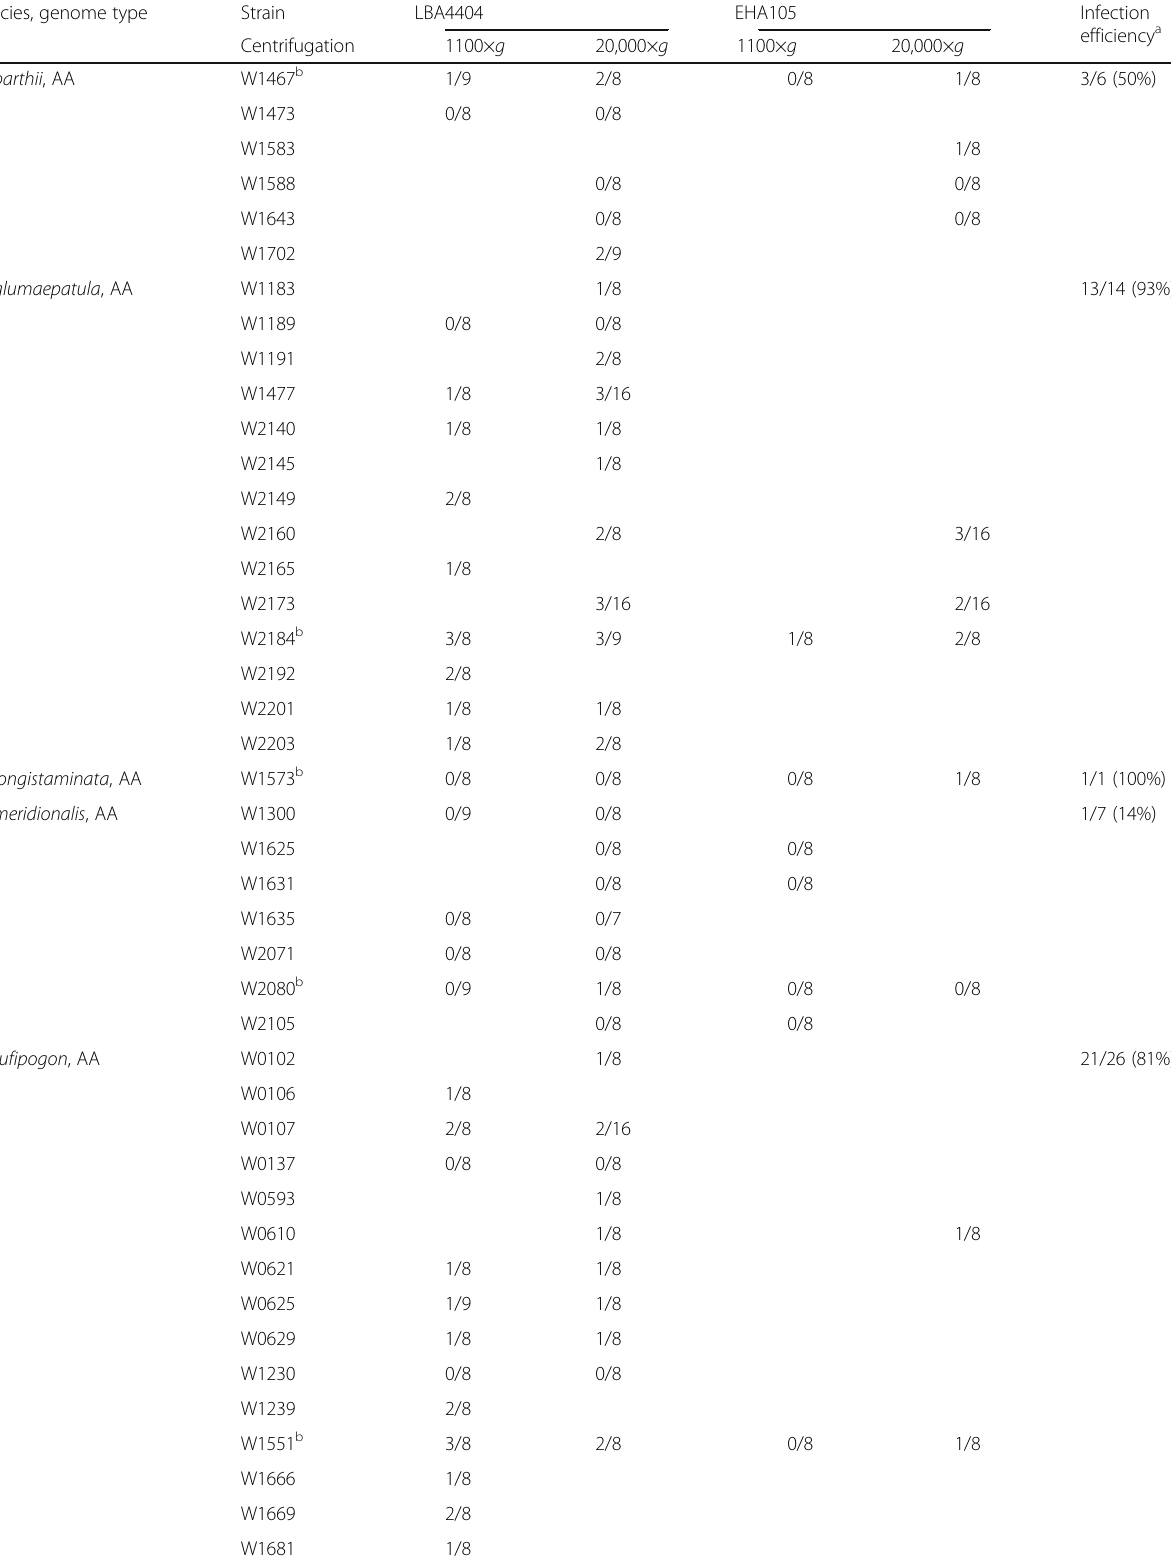
Table 5 Efficiency of Agrobacterium infection of calli induced from immature embryos of 76 accessions of wild Oryza Species, genome